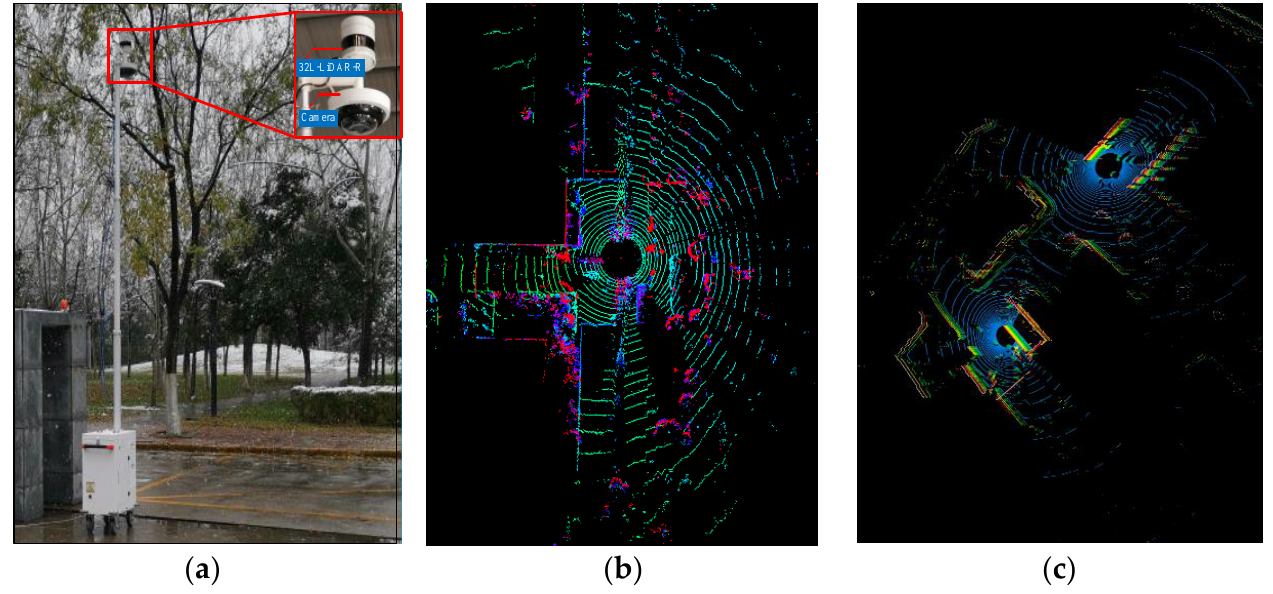
Figure 1. Roadside LiDAR and output point cloud. ( a ) 32L-LiDAR-R; ( b ) point clouds from a single LiDAR output; ( c ) point clouds from multiple LiDAR outputs.